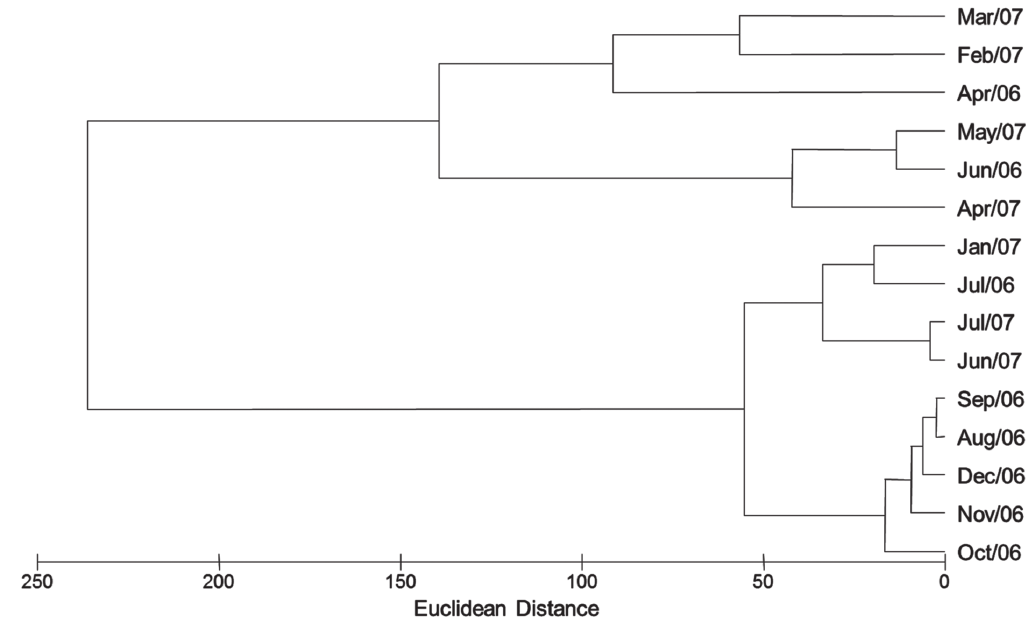
Figure 2 - Euclidean Distance dendrogram of the samples, based on environmental variables obtained throughout this study in Goiabeiras Beach, Fortaleza-Ceará-Northeastern